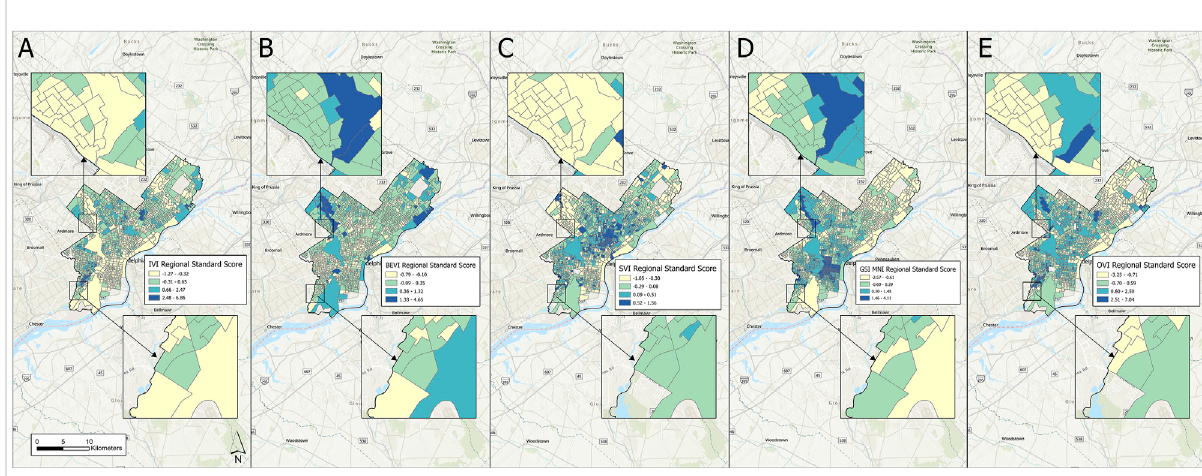
FIGURE 7 The z-scores of each index, including the overall index. The top inset in each panel is Manayunk, a gentri fi ed neighborhood sitting within a fl oodplain in northwest Philadelphia (Flanagan, 2010). The bottom inset in each panel is Eastwick, a low-income neighborhood also experiencing impacts from fl ooding in southwest Philadelphia (Bagwe, 2017). (A) Results of the Inundation Vulnerability Index as z-scores. (B) Results of the Built- Environment Vulnerability Index as z-scores. (C) Results of the Social Vulnerability Index as z-scores. (D) Results of the GSI Maintenance Needs Indexasz-scores. (E) Results oftheOverallVulnerabilityIndexasz-scores.BaseMapSource: Esri,DeLorme,HERE,TomTom,Intermap,incrementP Corp., GEBCO, USGS, FAO, NPS, NRCAN, GeoBase, IGN, Kadaster NL, Ordnance Survey, Esri Japan, METI, Esri China (Hong Kong), swisstopo, MapmyIndia, and the GIS User